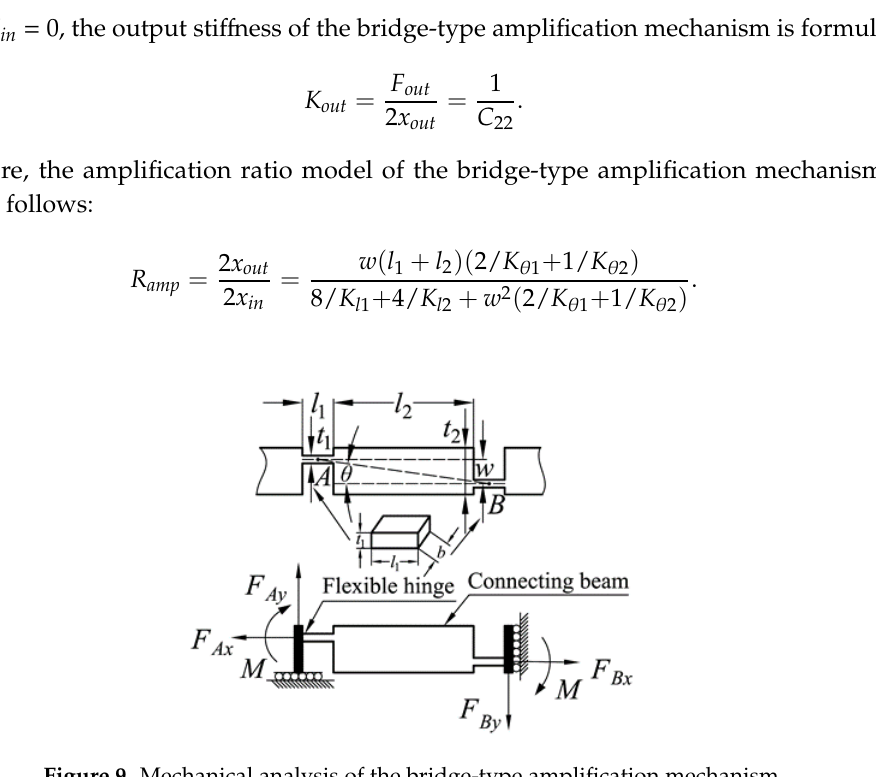
Figure 9. Mechanical analysis of the bridge-type amplification mechanism.